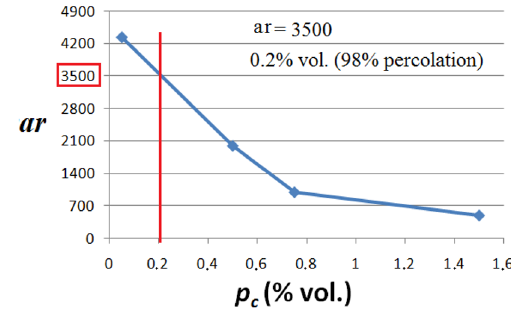
function for 100 consecutive c